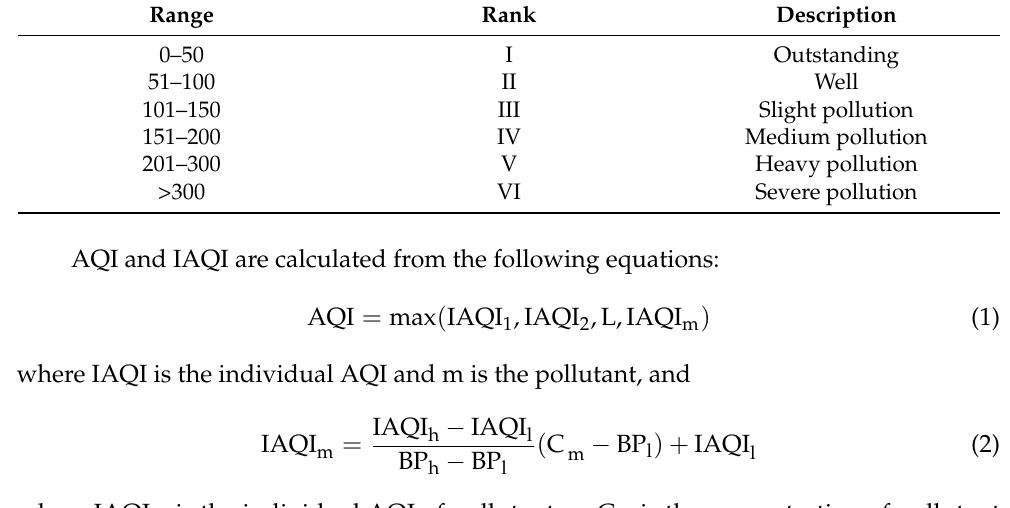
Table 1. Daily individual AQI (IAQI) is calculated from the concentrations of individual